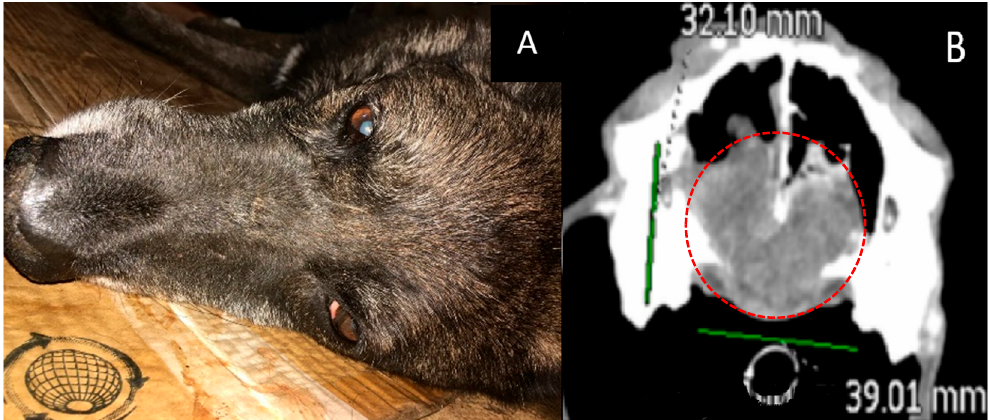
Figure 2. Male dog “John” (14 years old) with chondrosarcoma in the nasal area with impaired nasal breathing and nasal discharge and tumor recurrence after repeated surgical treatment. Animal appearance before irradiation ( A ). Head CT after irradiation ( B ) with a tumor 32 × 39 × 47 mm in size (green lines, dashed red circle).